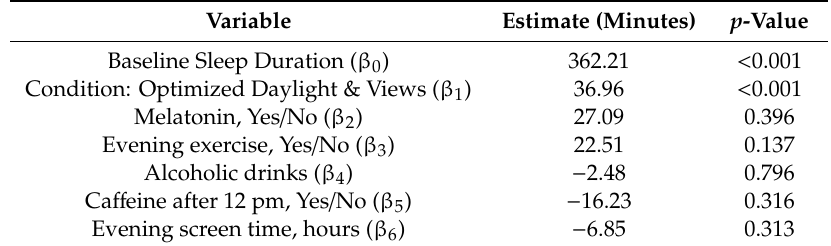
Table 3. Linear mixed-e ff ects model of sleep duration by o ffi ce condition and lifestyle factors (use of melatonin, engagement in exercise, number of alcoholic drinks, ca ff eine intake after noon, and evening screen time duration) (N subjects = 24, N observations =